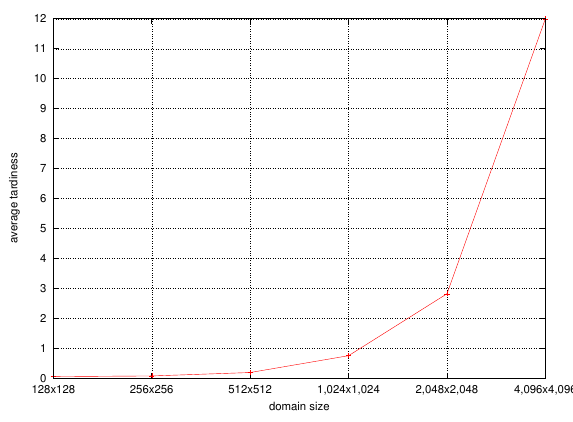
Fig. 10: Average physics simulation tardiness.